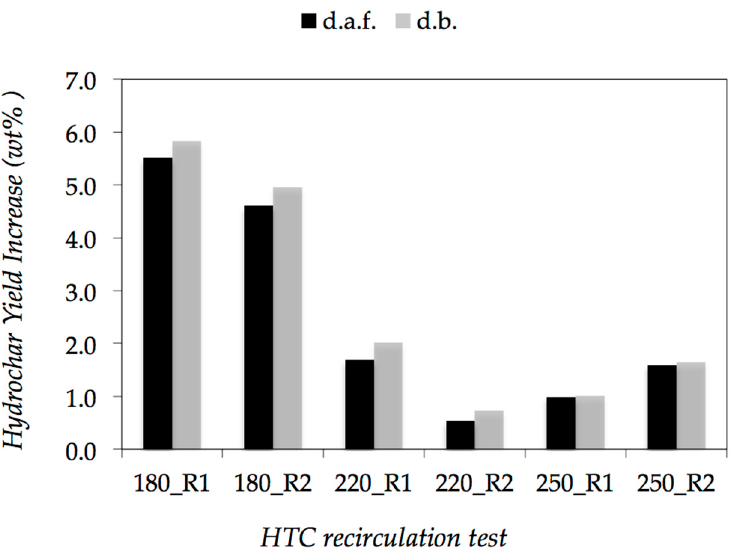
Figure 3. Contribute of ash content in hydrochar yield increase after recirculation steps.